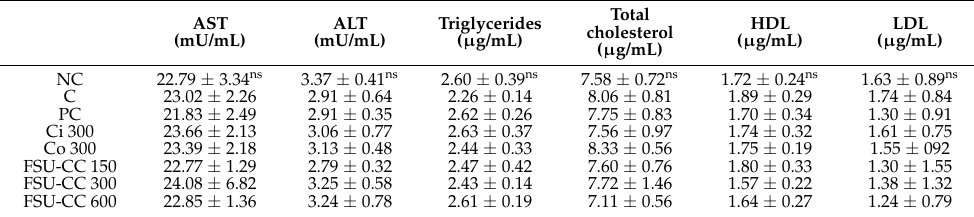
Table 1. Changes in the levels of serum alanine transaminase (ALT), aspartate transaminase (AST), triglycerides, total cholesterol, high-density lipoprotein (HDL) cholesterol, and low-density lipopro- tein (LDL) cholesterol in the hyperuricemia-induced mice supplemented with and without Ci, Co, or FSU-CC. Total AST ALT Triglycerides cholesterol (mU/mL) (mU/mL) ( µ g/mL) ( µ